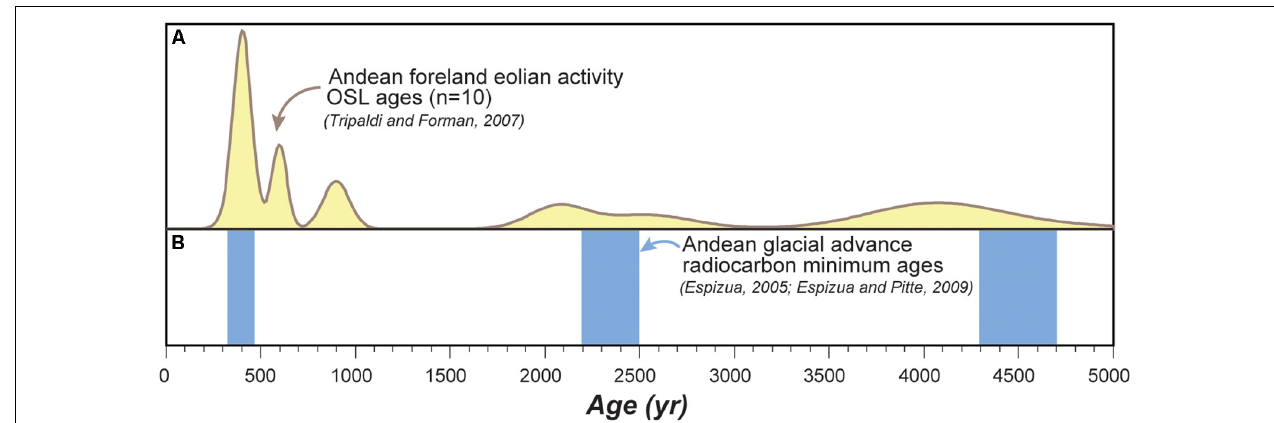
FIGURE 8 | Holocene chronology of eolian and glacial activity in NW Argentina. (A) Optically Stimulated luminescence (OSL) ages from Andean Piedmont eolian fields Medanos Grande and Medanos Negros located east of Sierra Valle Fertile ( Figure 7 for location; Tripaldi and Forman, 2007). (B) Radiocarbon minimum ages from terminal moraine glacial deposits in the Andes of Mendoza province (Espizua, 2005; Espizua and Pitte, 2009). Note the overlap between glacial advance and subsequent eolian activity.